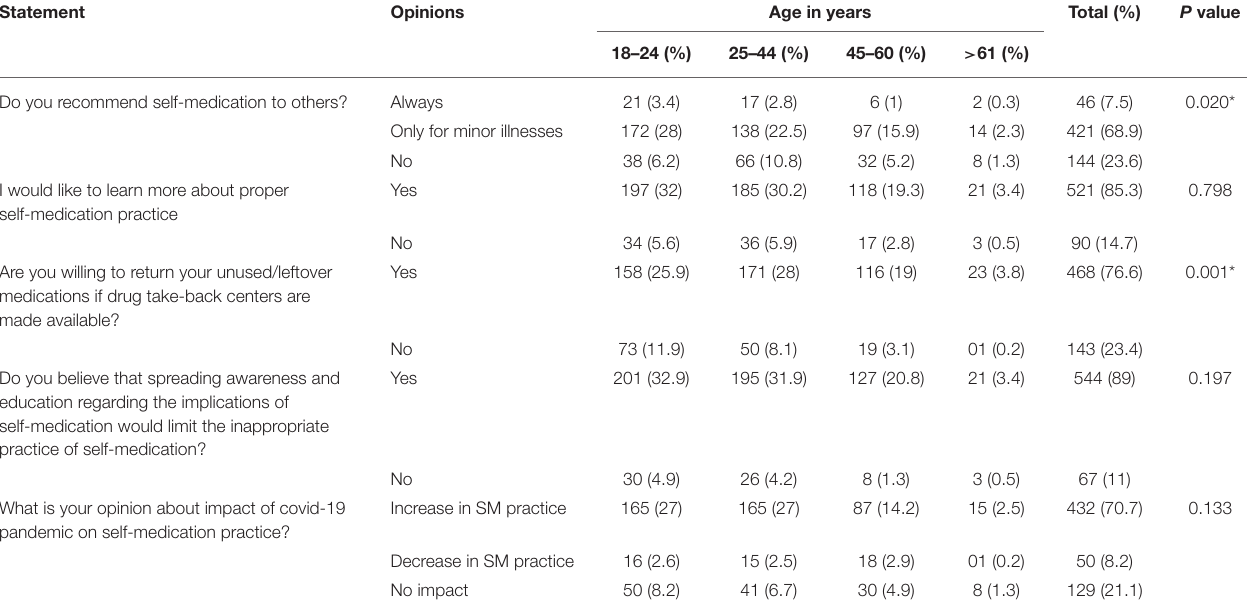
TABLE 6 | Opinions and recommendations toward